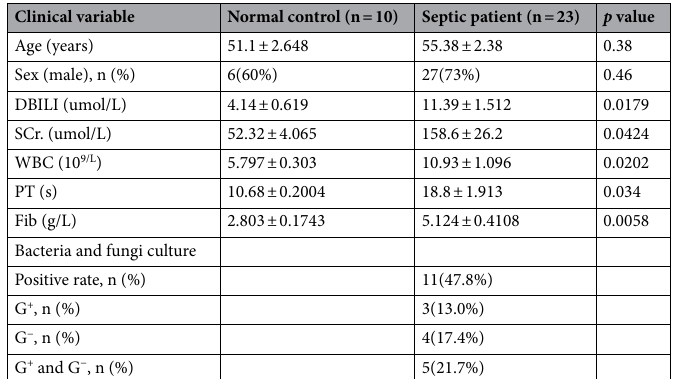
Figure 1. Study workflow and screening of differentially expressed genes. ( A ): Workflow of this study. Firstly, human blood samples were collected from septic patients and healthy volunteers. RNA-seq technology and a bioinformatical approach were used for screening differentially expressed genes. Secondly, PPI analysis combined with clinical characteristics was used to make the final definition of 6 potential pivotal target genes. Lastly, single-cell sequencing was used to identify the cell lineage location of target genes. And peripheral blood sequencing from the septic mouse model was used to verify pivotal the expression profiles of key genes. ( B ): Volcano plot to screen differentially expressed genes. Horizontal ordinate presented as log 2 (FC), each dot indicating a gene. Red color as upregulation; Blue color as downregulation. CD247, BCL9L, CD96, SAMD3 and BCL11B were downregulated in the septic group, while MAFG were up-regulated in the septic group. Clinical